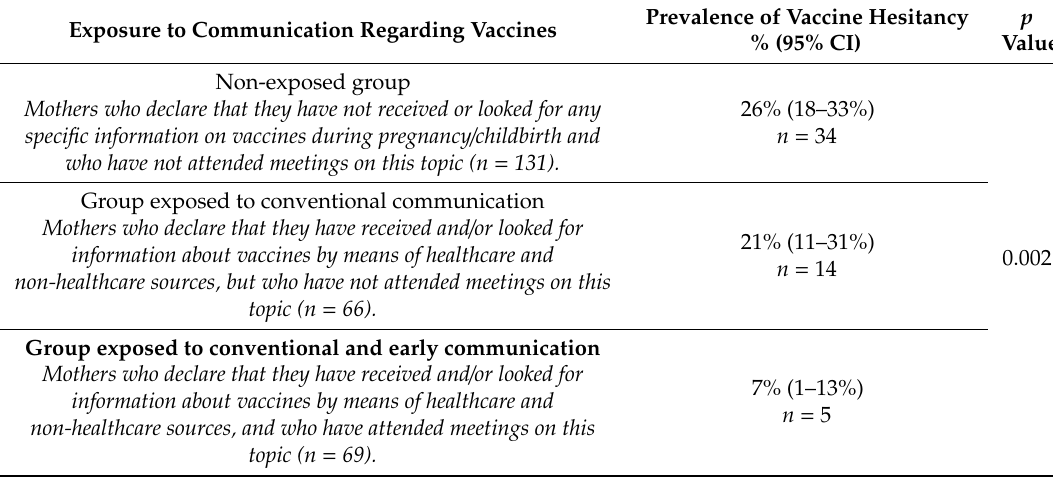
Table 3. Prevalence of vaccine hesitancy in mothers with di ff erent exposures to communication regarding vaccine. Exposure to Communication Regarding